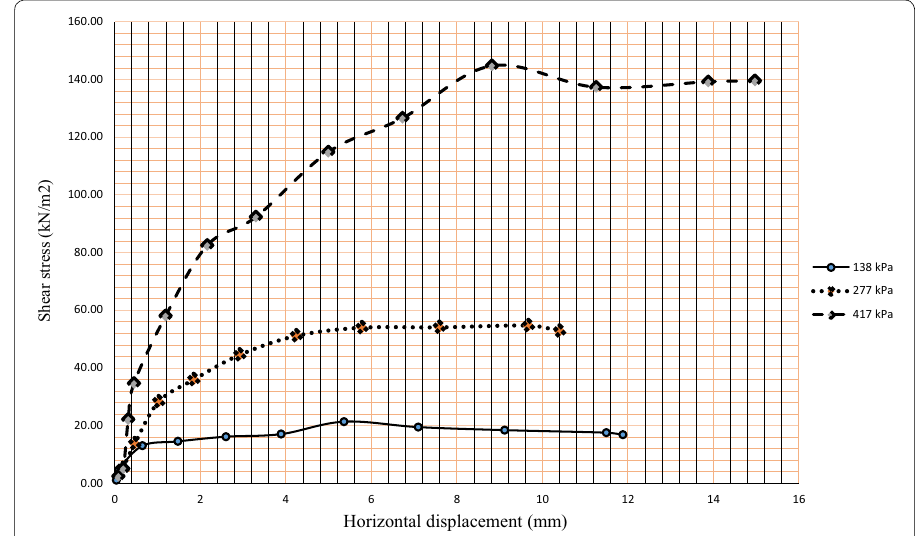
Fig. 2 Shear stress versus horizontal displacement curve for soil to soil test for specimens set 1